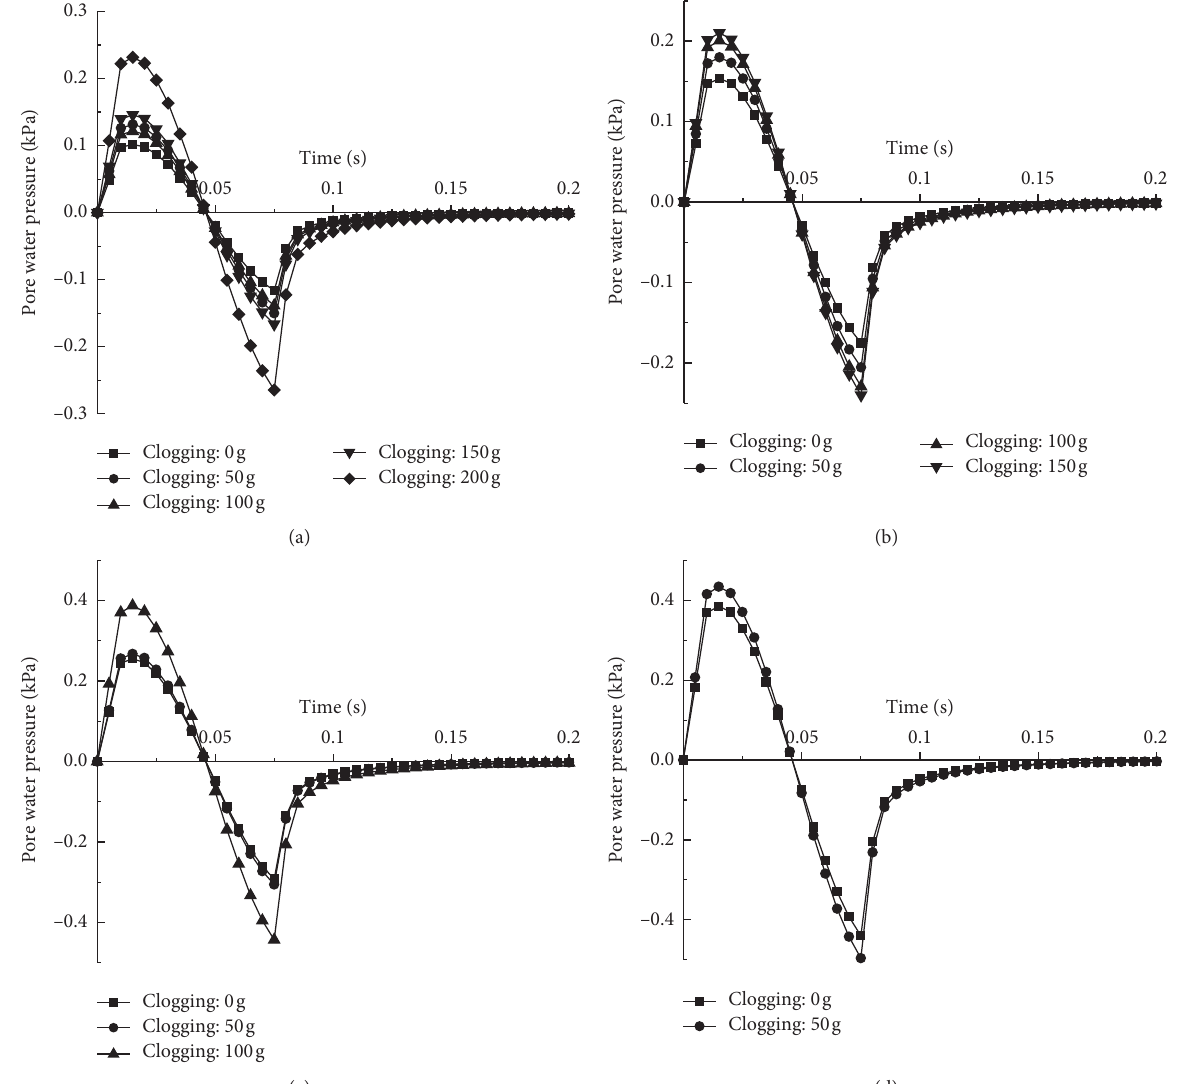
Figure 9: Pore water pressure at a depth of 6 cm ((a) void rate is 25%; (b) void rate is 23%; (c) void rate is 20%; (d) void rate is